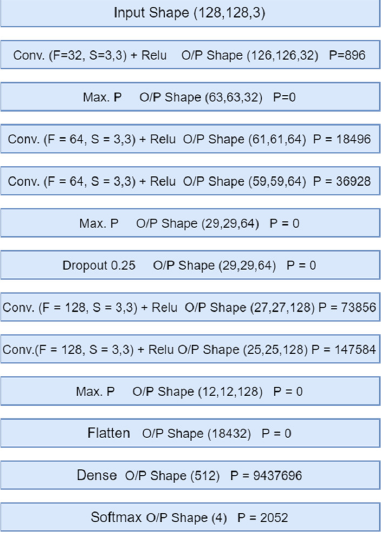
Figure 4. The architecture of a CNN classifier is used to test the classification performance of differ- ent generative models. Here P, Max. P, F, and S represent the parameters, maximum pooling, num- ber of filters, and filter size,